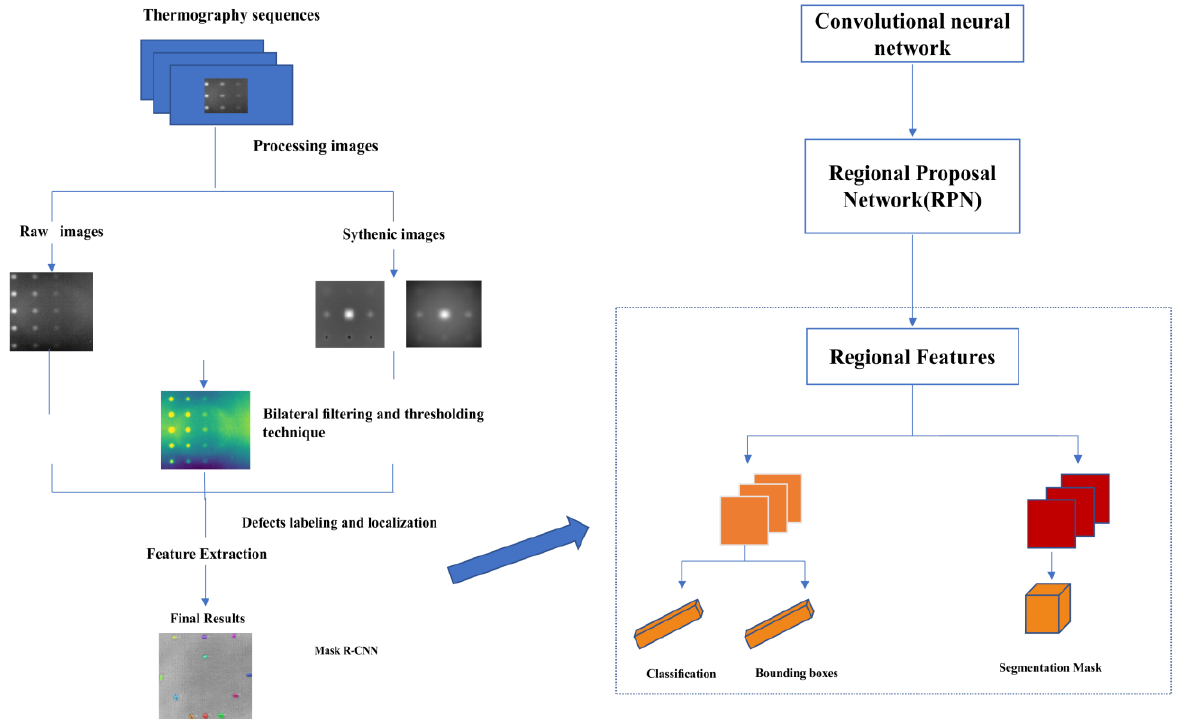
Figure 2. Proposed segmentation strategy.